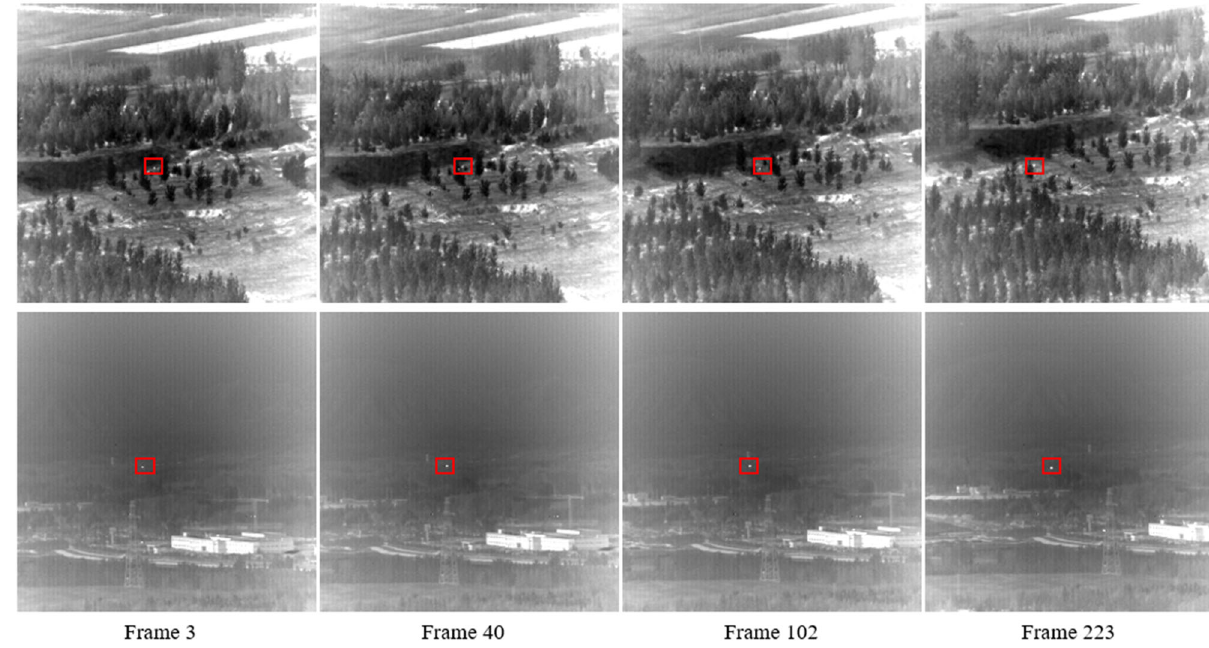
Fig. 6 The results of target tracking in infrared images using our framework in different frames in two streams